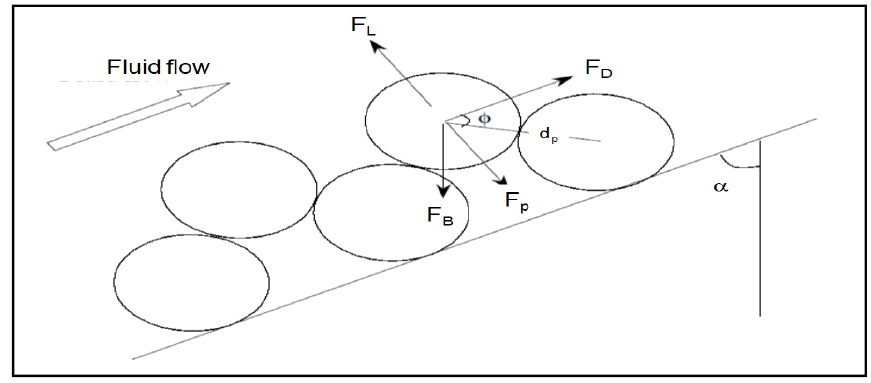
Figure 12. Forces acting on a single particle laying on a sand bed (Ramadan et al. [18]).